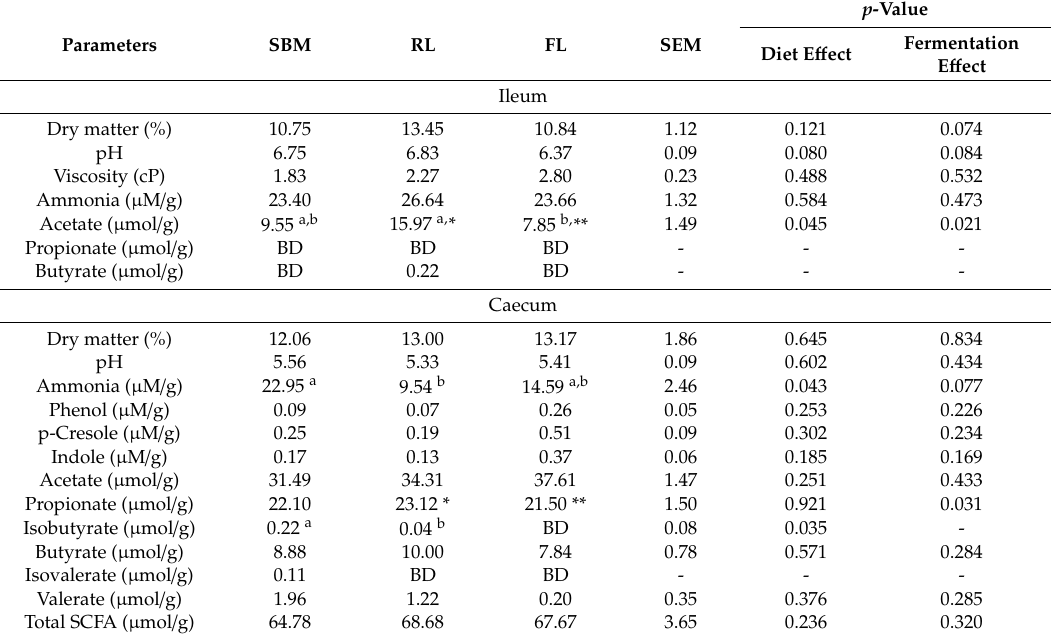
Table 4. Indicators of fermentation in fresh ileum, cecal